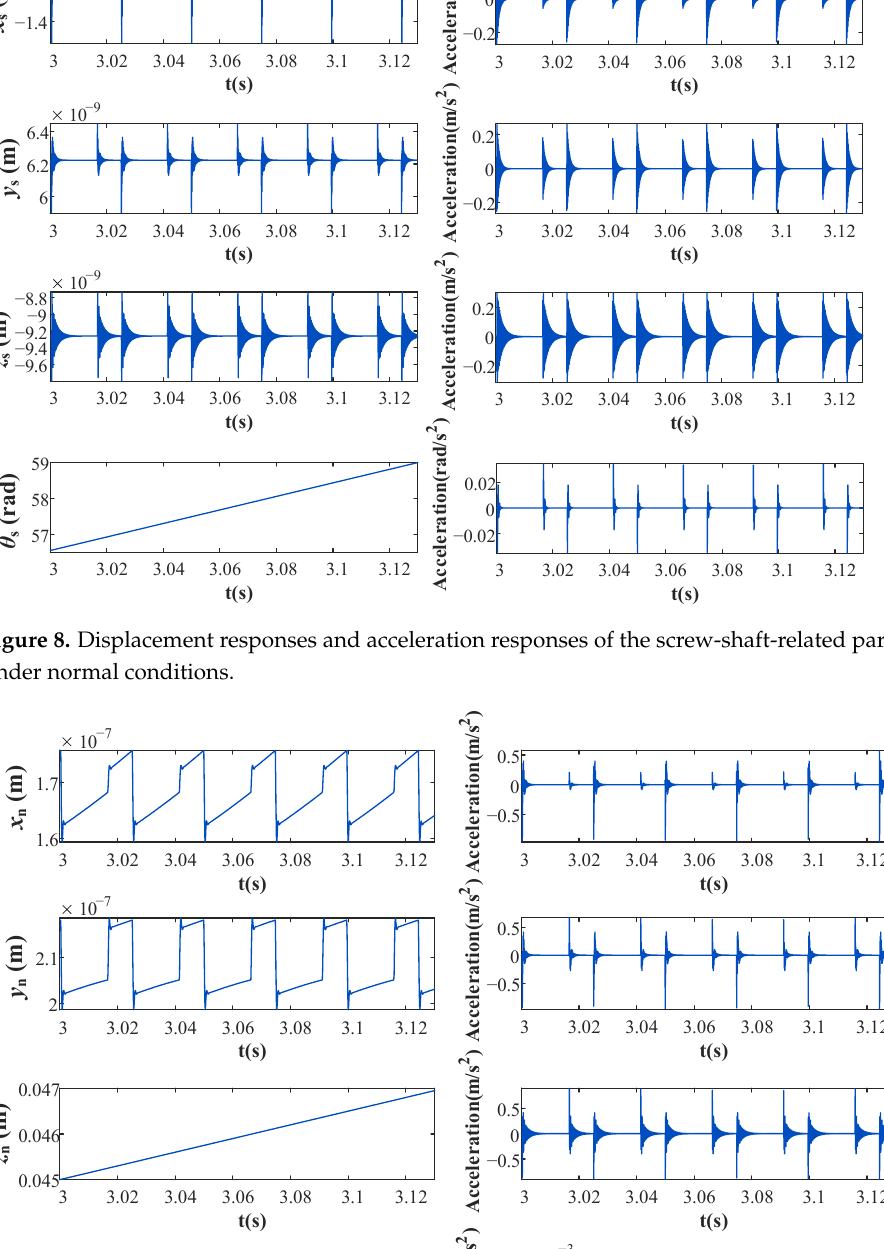
of the nut, the total elastic restoring force changes accordingly, and the nut displacement exhibits similar behavior to that of step responses, as shown in Figure 9. For the screw shaft, the impact generated by the balls entering and exiting the return device can be re- garded as an external vibration excitation source, which generates impacts at different amplitudes but the same frequency. Then, the screw shaft exhibits forced vibration under the excitation of these impacts and the constraint of the bearings. Therefore, the displace- ment of the screw shaft exhibits behavior similar to that of impulse responses, as shown in Figure 8. The displacement and acceleration responses of the system after the spalling fault is implanted into the model are shown in Figures 10 and 11. Figure 10 shows that the re- sponses of the screw-shaft-related parameters under faulty conditions are also impulse responses, similar to those under normal conditions. However, besides the two impacts of the ball entering and exiting the return device, there is another fault impact in both displacement and acceleration responses under faulty conditions. Furthermore, in the dis- placement and acceleration responses of the nut-related parameters, fault impacts can be more obviously identified. As shown in Figure 11, it is obvious that there is an additional fault impact between the two original impacts in the displacement responses of x n and y n .